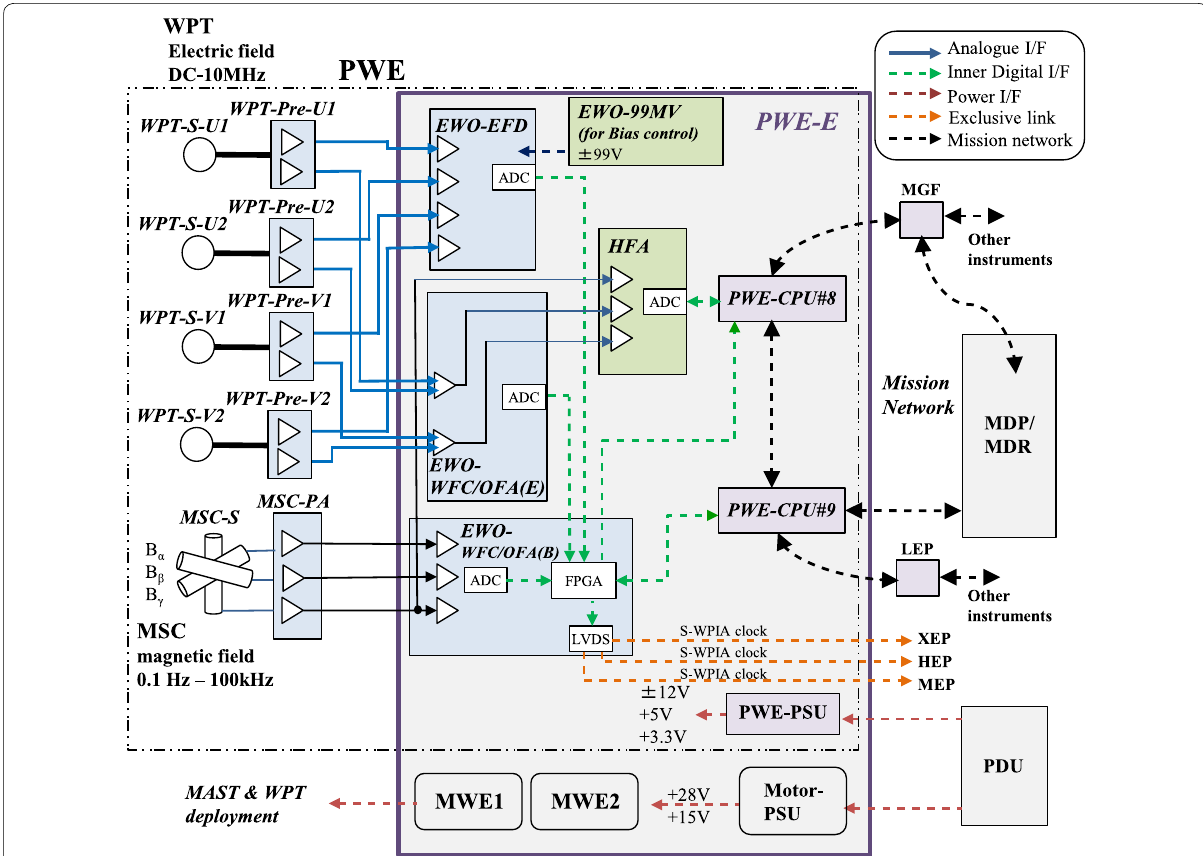
Fig. 1 A block diagram of the PWE (Reproduced with permission from Kasahara et al.